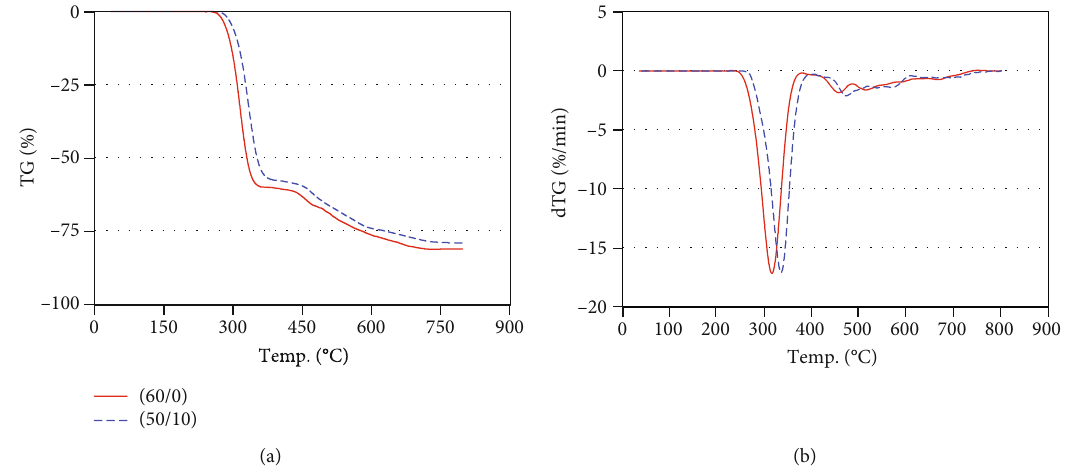
Figure 8: TG (a) and dTG (b) thermograms of 60/10 and 50/10 samples. Table 2: The e ff ect of EeRSO on the thermal stability of PVC